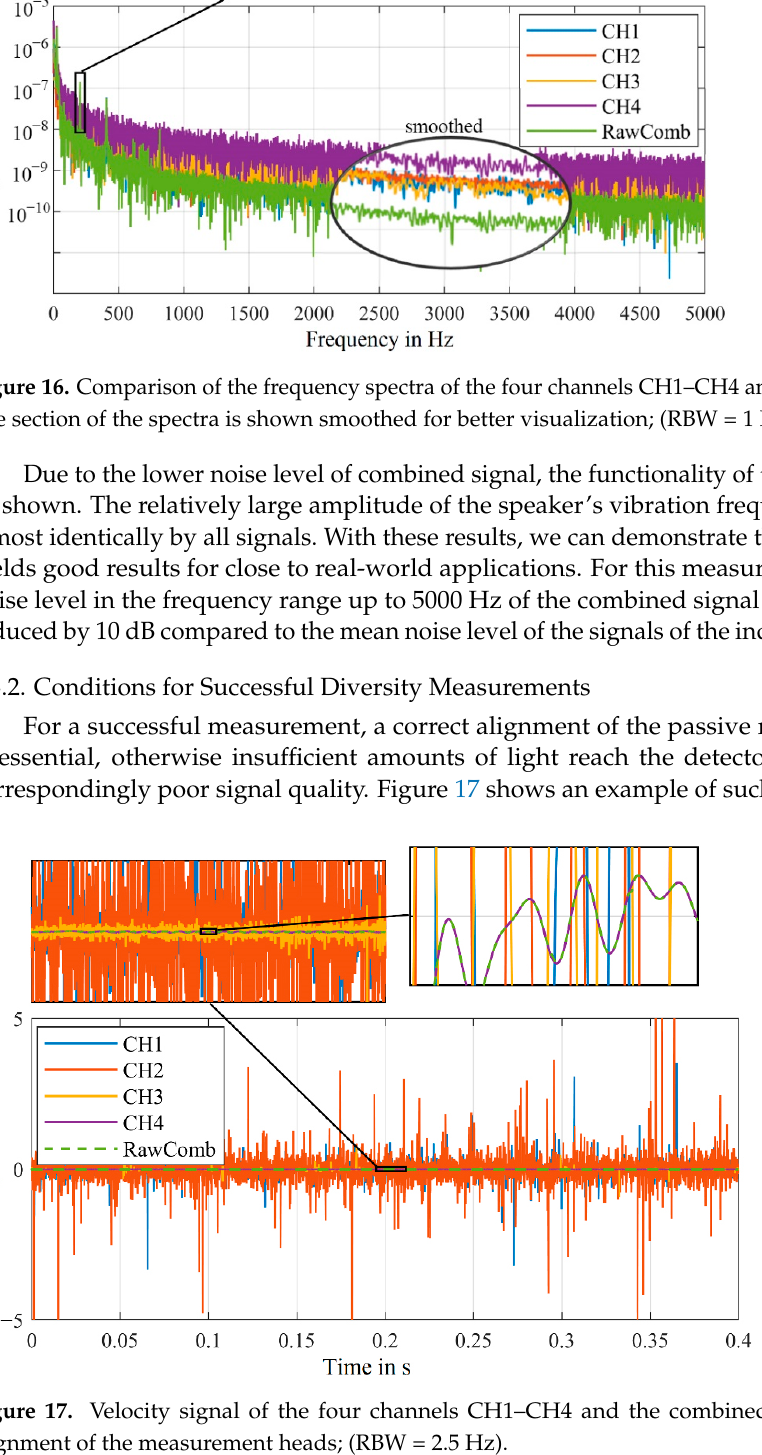
Figure 15. Comparison of the demodulated displacement signals of the four channels CH1–CH4 and the combined signal; (RBW = 1 Hz).